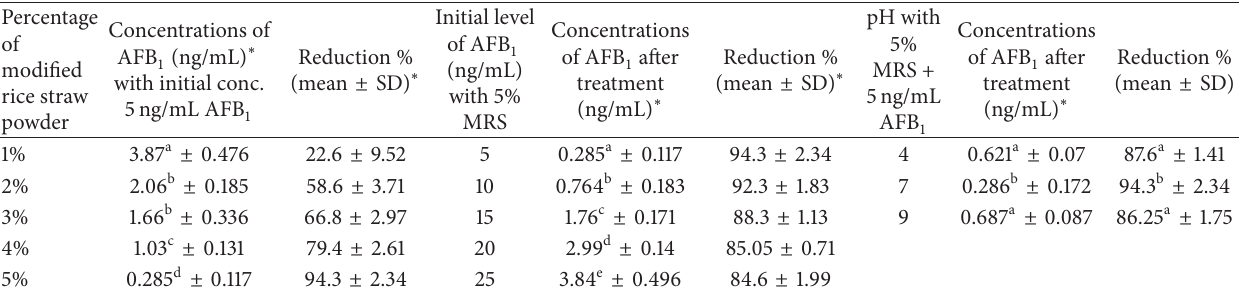
Table 2: Effect of modified rice straw powder and different AFB 1 and pH values on the removal of aflatoxin B 1 at 25 ∘ C for 30 min ( 𝑛 = 3 ) in aqueous